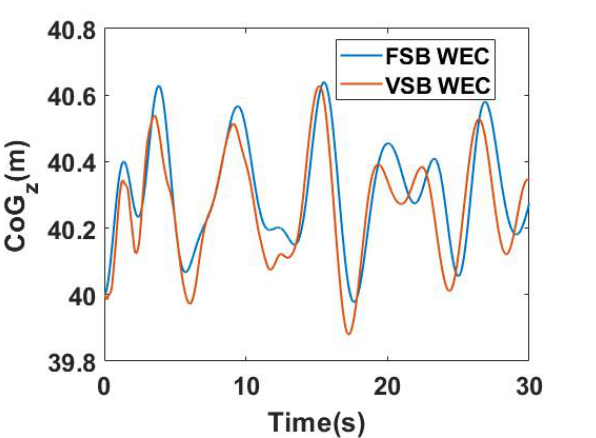
Figure 22. z-directional motion of center of gravity compared between FSB WEC and VSB